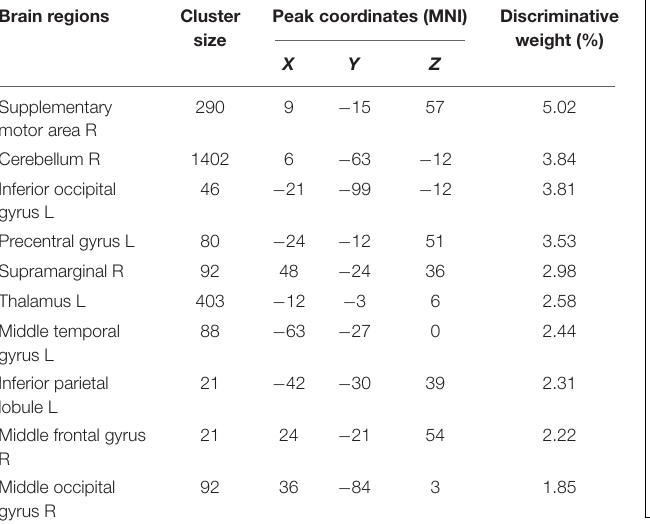
Frontiers in Neuroscience |